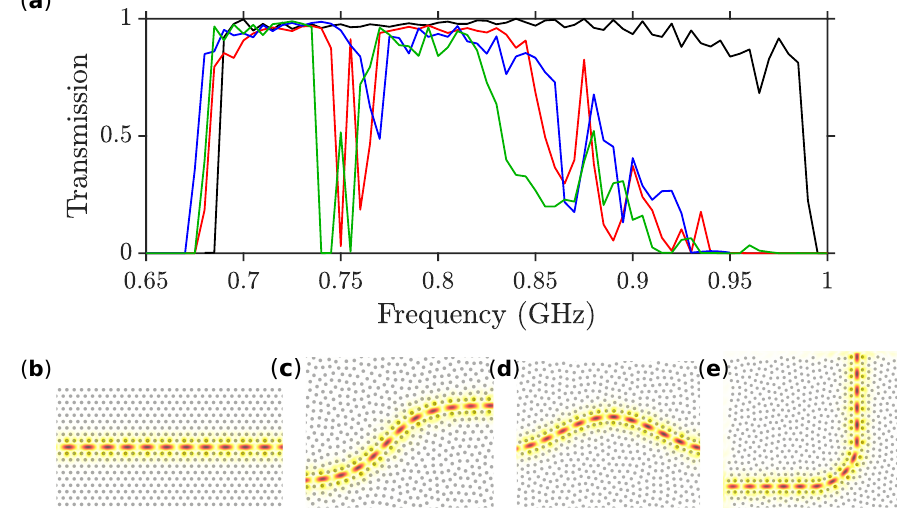
( a ) Transmitted power for the waveguides in Figure 4a–c as shown by the blue, red, and green lines, respectively. With the black lines the corresponding transmitted power of a straight waveguide is shown with the black line for comparision. A snapshot of the elastic field magnitude at a propagating frequency of 0.71 GHz is shown in ( b – e ) for the straight waveguide, and the waveguides in Figure 4a–c,